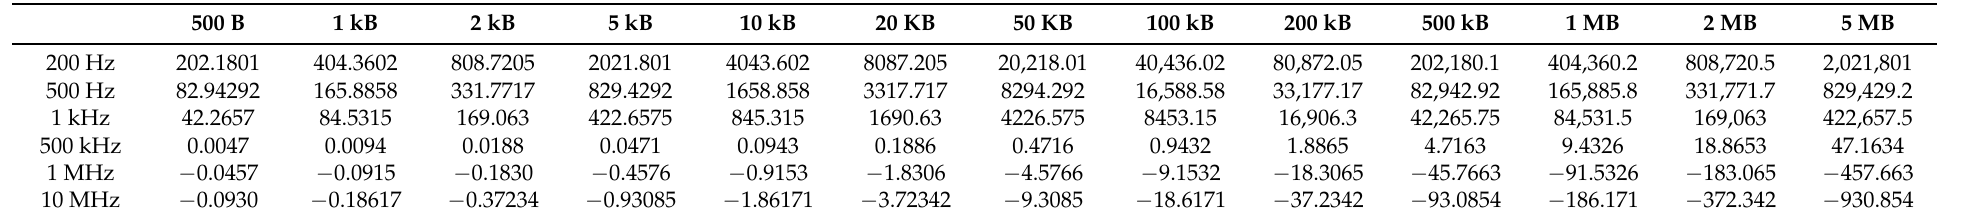
Table 3. Threshold difference values between offloading and local for the end node ( T of f − T loc ).